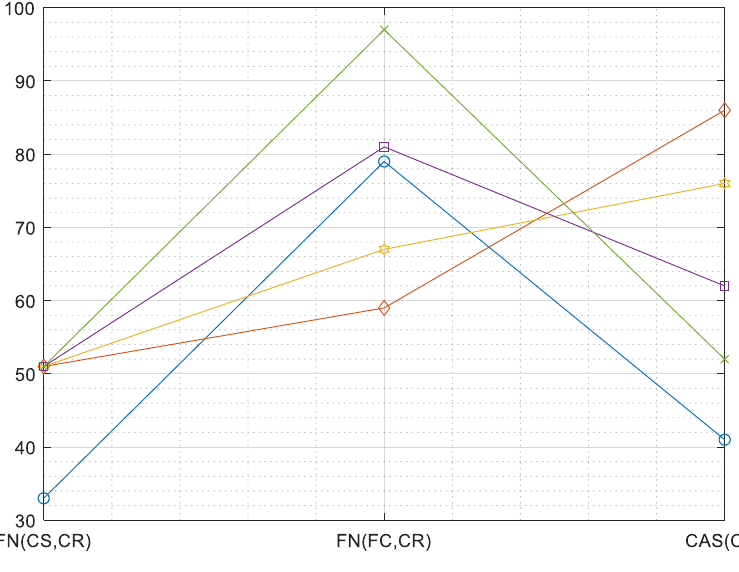
Figure 8. Collusion attack strength ( CAS ) .